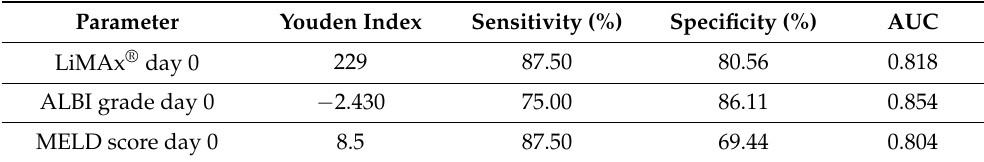
Table 3. Predictive value of LiMAx, ALBI grade, and MELD score for hepatic decompensation (defined as CPS B7 or more) 28 days after RE (whole cohort).